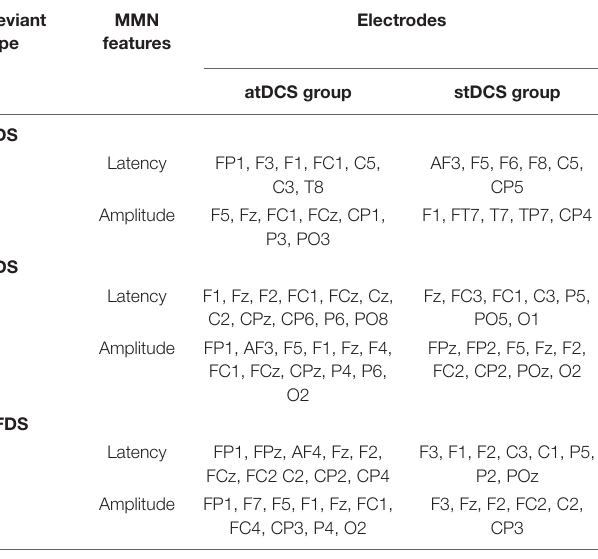
TABLE 4 | Mean amplitudes and latencies of MMN in two groups of children at the Fz electrode.